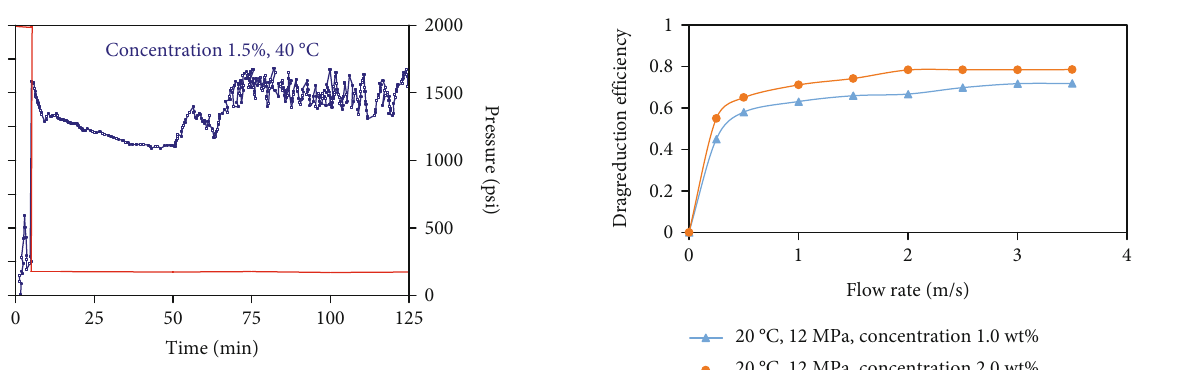
Figure 4: Viscosity versus shear time curve at a thickener concentration of 1.5%.